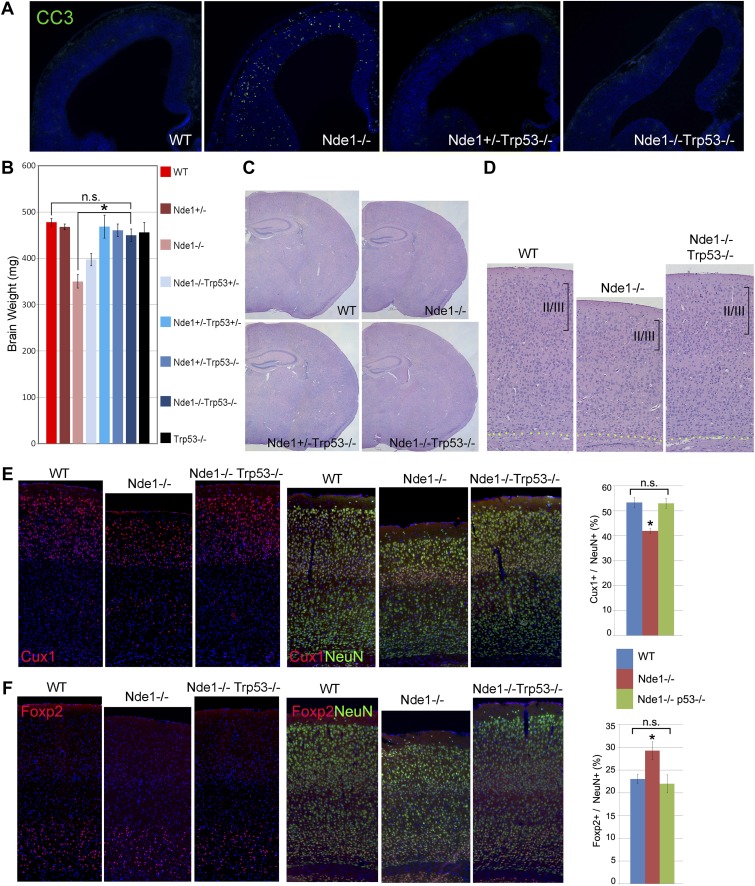
Restoration of the size and structure of the Nde1−/− brain by abrogating p53.(A) Immunohistological analyses of cleaved caspase 3 (CC3, green) in wild-type, Nde1−/−, Nde1+/−Trp53−/−, and Nde1−/−Trp53−/− neocortices at E12.5. (B) Brain weight of Nde1−/−, Nde1−/−Trp53−/− mutant mice and their littermates at post-natal for 3 to 4 weeks. Data are mean ± SD. Significant overall differences were found among wild-type and Nde1–Trp53 double mutants by ANOVA (p < 0.0001). Pairwise comparisons showed that the brain mass of Nde1−/−Trp53−/− mice (n = 8) was significantly increased compared to that of Nde1−/− mice (*p < 0.0001), but not significantly different from that of the wild-type mice (n.s., p = 0.06). (C) H&E stained brain sections of wild-type, Nde1−/−, Nde1+/−Trp53−/−, and Nde1−/−Trp53−/− mice reveal normal size and anatomical structure of the Nde1−/−Trp53−/− brain. (D) H&E stained cortical sections of wild-type, Nde1−/−, and Nde1−/−Trp53−/− brains, showing restored layer II/III cortical neurons in the Nde1−/−Trp53−/− brains. (E) Immunohistological and quantitative analyses of the number and distribution of Cux1+ (red) superficial layer cortical neurons. Cortical neurons were identified by NeuN immunoreactivities (green); nuclei DNA was stained with Hoechst 33342 and shown in blue. Data are presented as mean ± SD in percentage of total NeuN+ neurons (n = 5). Significant overall differences were found among wild-type, Nde1−/−, and Nde1−/−Trp53−/− brains by ANOVA (p < 0.0001). Pairwise comparisons indicated that compared to the wild-type, Cux1+ neurons were significantly decreased in the Nde1−/− brains (*p < 0.0001), but not significantly changed in Nde1−/−Trp53−/− brains (n.s., p = 0.94). Compared to Nde1−/−, Cux1+ neurons were significantly increased in Nde1−/−Trp53−/− brains (p < 0.0001). (F) Immunohistological and quantitative analyses of the number and distribution of Foxp2+ (red) deep layer cortical neurons. Significant overall differences were found among wild-type, Nde1−/−, and Nde1−/−Trp53−/− brains by ANOVA (p < 0.0001). Pairwise comparisons indicated that compared to the wild-type, Foxp2+ neurons were significantly increased in the Nde1−/− brains (*p<0.005), but not significantly changed in Nde1−/−Trp53−/− brains (n.s., p = 0.77). Compared to Nde1−/−, Foxp2+ neurons were significantly decreased in Nde1−/−Trp53−/− brains (p = 0.001).